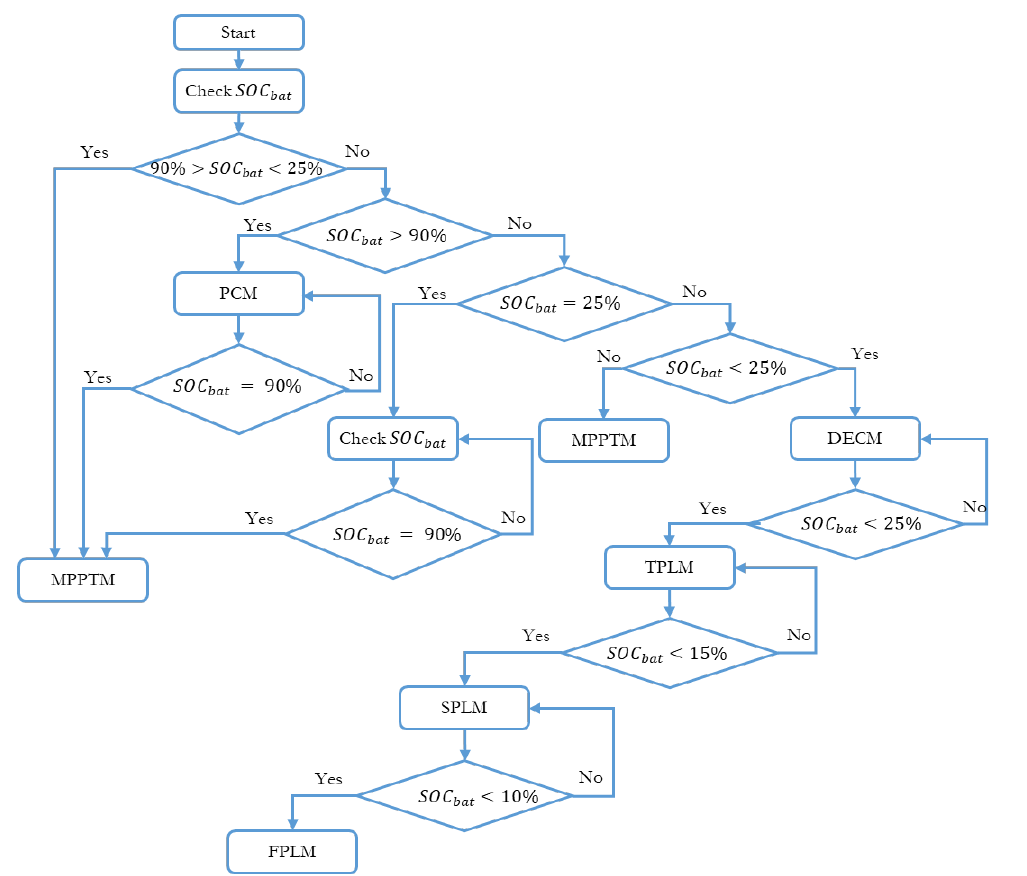
Figure 14. Power management flowchart for the battery storage system.